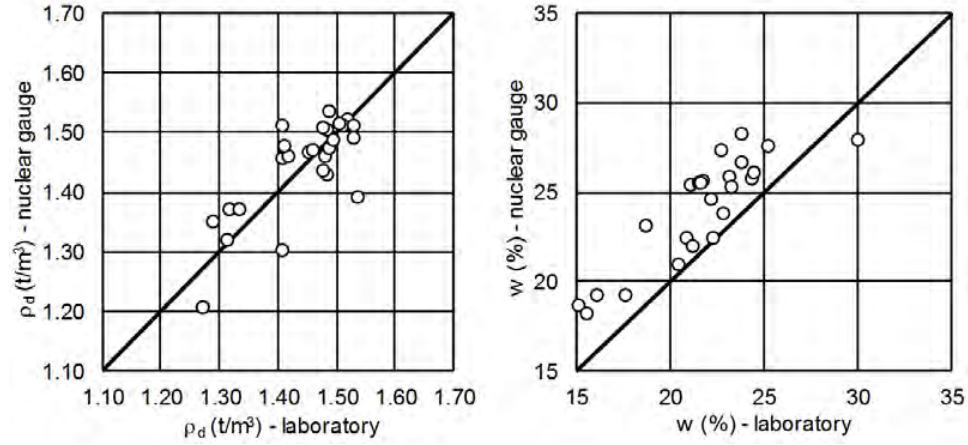
Figure 12. Comparison between nuclear gauge and laboratory measurements of water content and dry